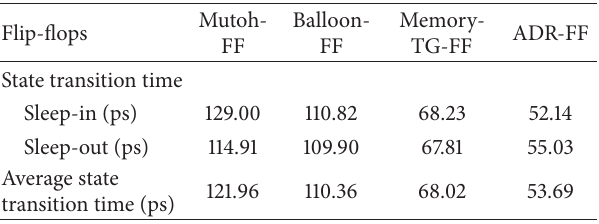
Table 5: The state transition time of different data retention flip- flops.